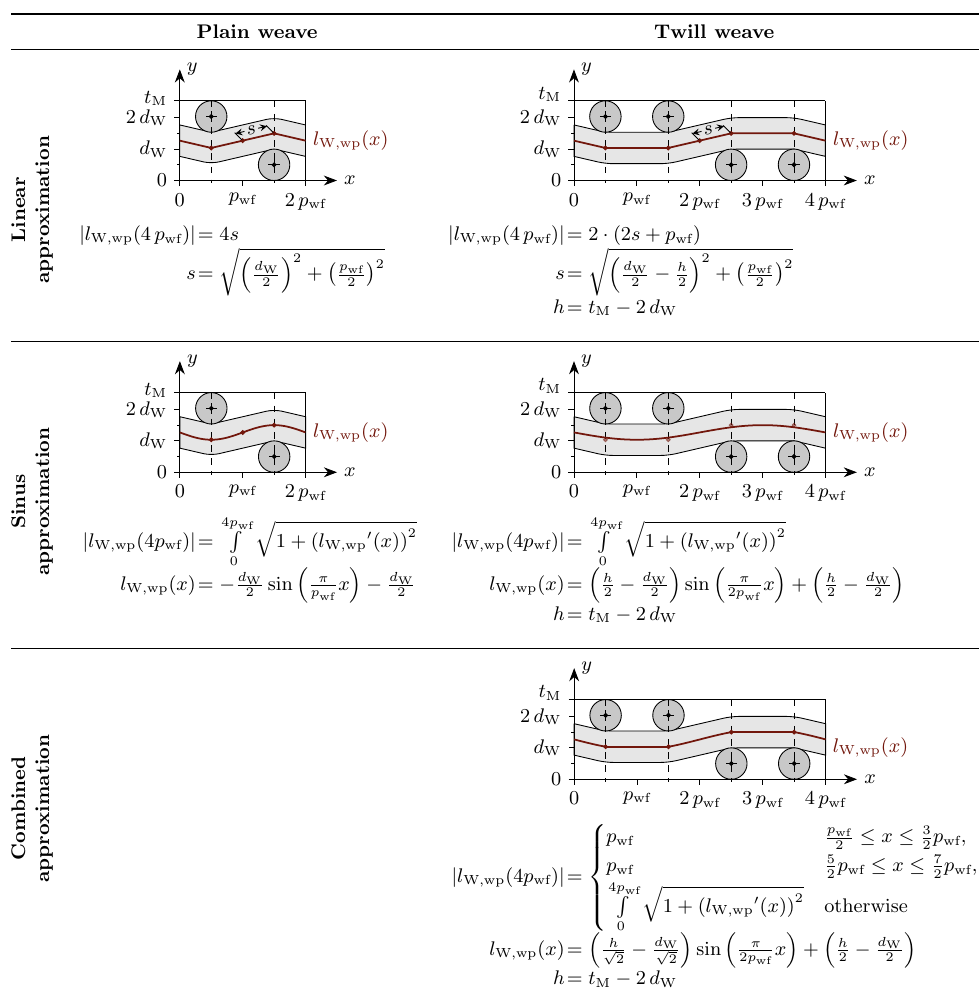
Figure 6. Approximation approaches for calculating the wire length in the warp direction l W,K for meshes with plain and twill weave 2/2 with d W = d wp = d wf and p wf = d W + w wf